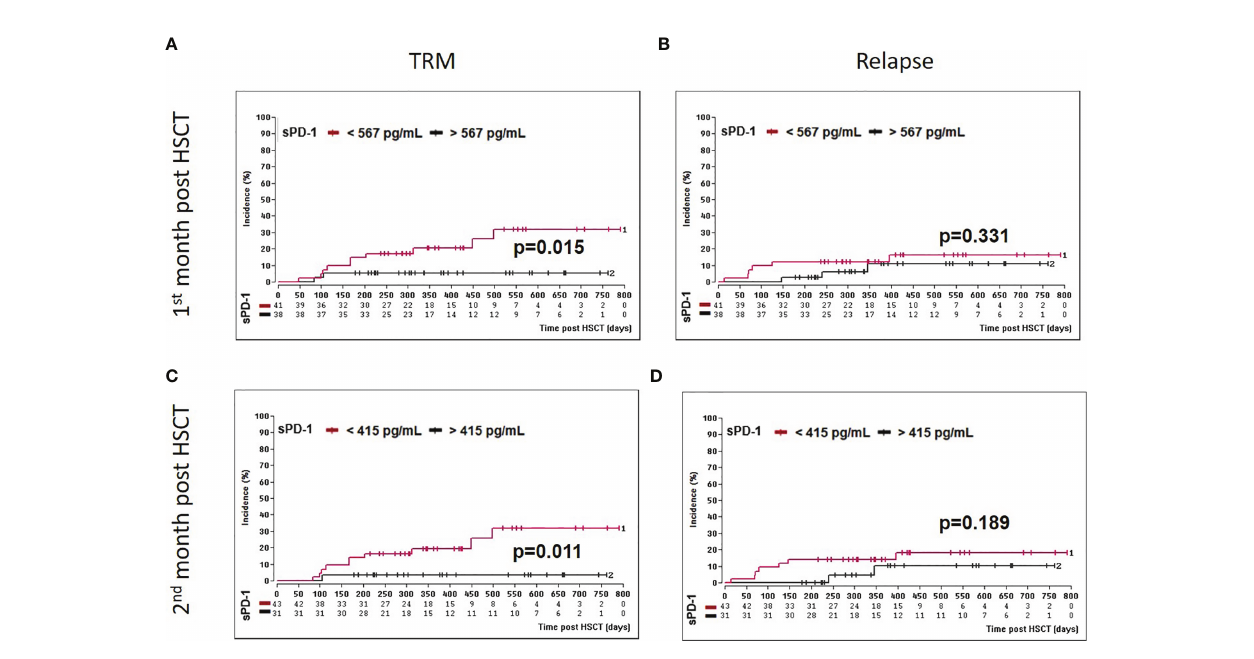
FIGURE 6 | Association of low sPD-1 levels with reduced TRM. Patients were divided in two groups according to cut-off levels obtained one (A, B) month (< or >567 pg/ml) and two (C, D) months (< or >415 pg/ml) post HSCT. Estimated cumulative incidence curves of patients with TRM (A, C) and relapse (B, C) as competing event are shown for patients with sPD-L1 < 567 pg/mL (A, B) or <415 pg/ml (C, D) in brown and compared to patients with sPD-1 >567 pg/mL (A, B) or >415 pg/ml (C, D) in black.